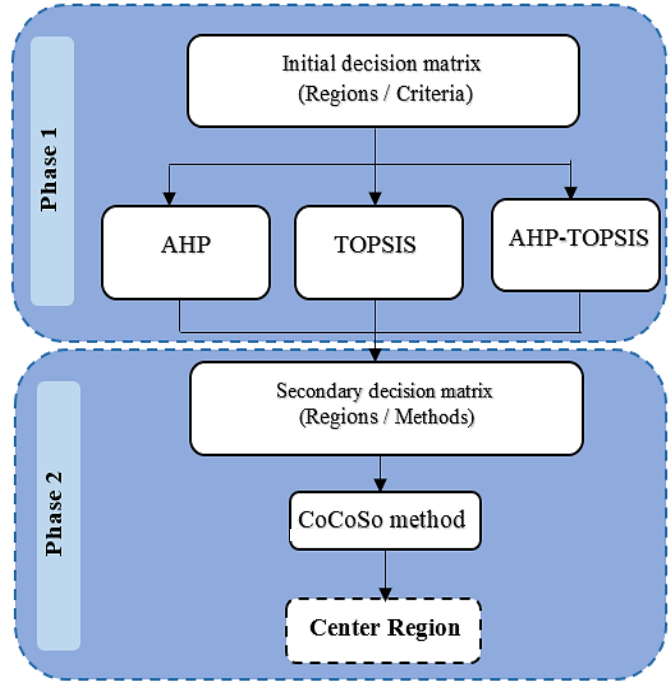
Fig. 1. The flowchart of the hybrid two-phase